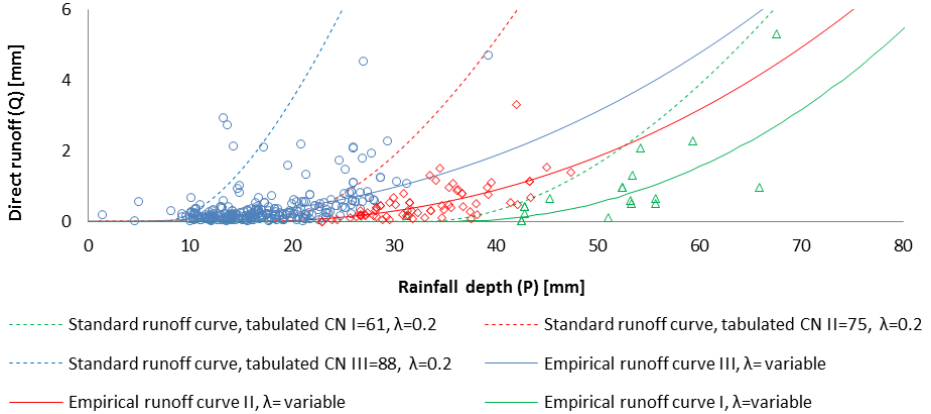
Figure 3. Regional empirical runoff curves and standard runoff curves based on tabulated curve numbers derived for the Upper Hron River